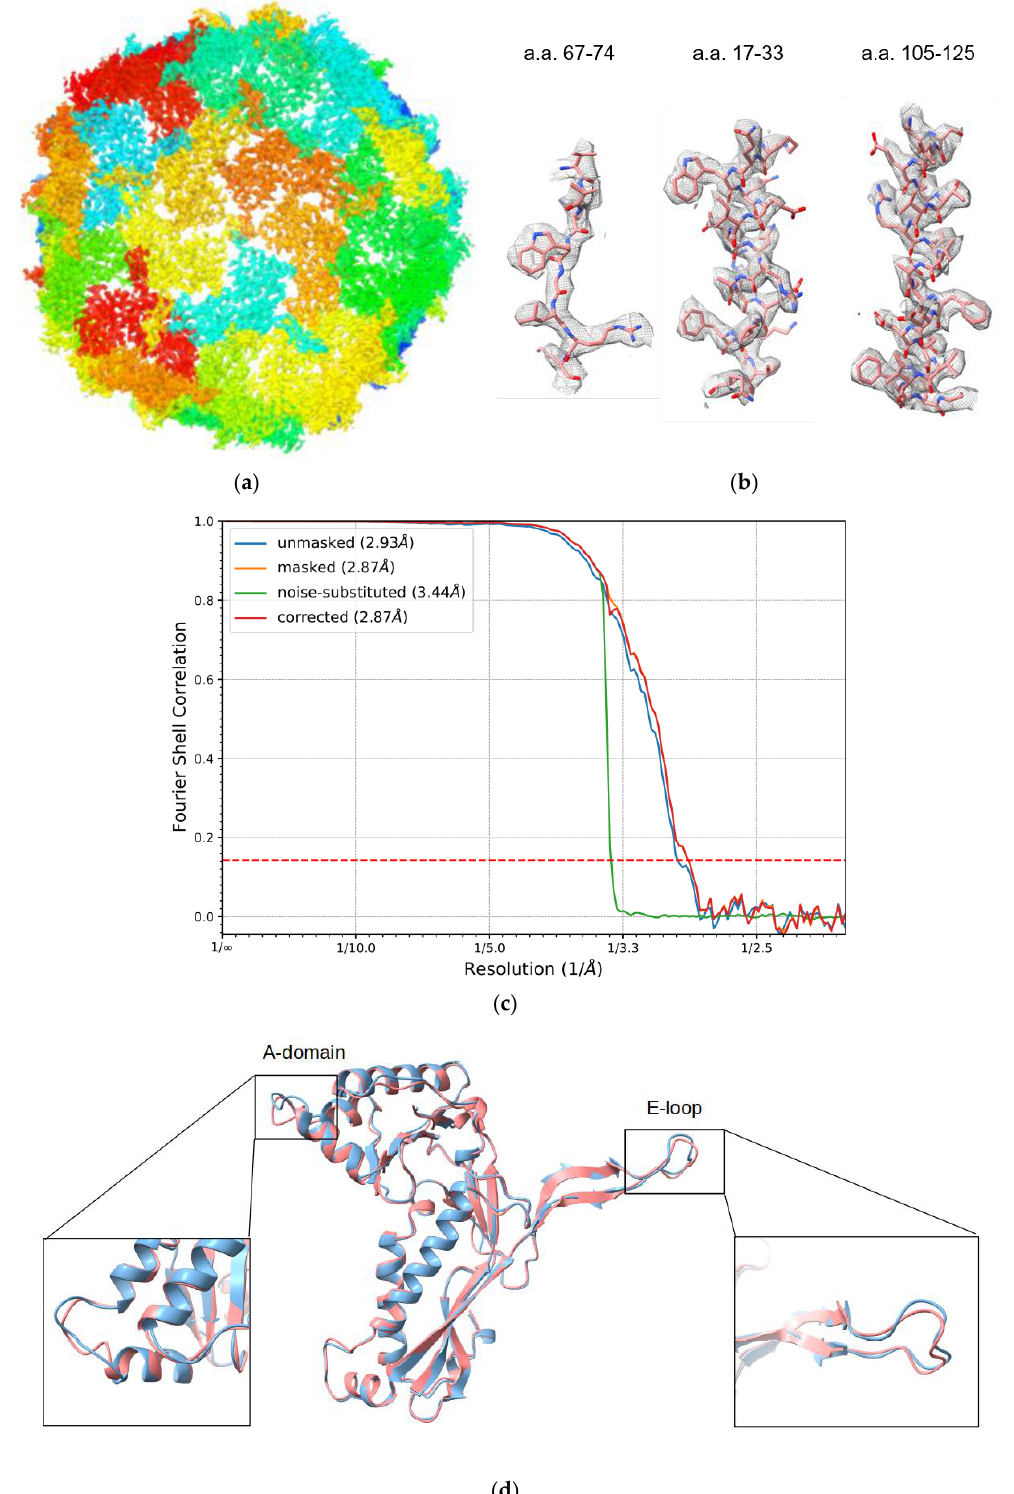
Figure 3. Overall structure of IDM complex-loaded T. maritima encapsulin. ( a ) The sharpened density map of Encap / IDM complex from the icosahedral reconstruction. ( b ) The closeup view of the side-chain densities of short segments of a.a.67-74, a.a.17-33, and a.a.105-125. ( c ) The FSC curve of the reconstructed cryo-EM half maps. ( d ) Structure alignment of the Encap (coral) and Encap / IDM monomer (light